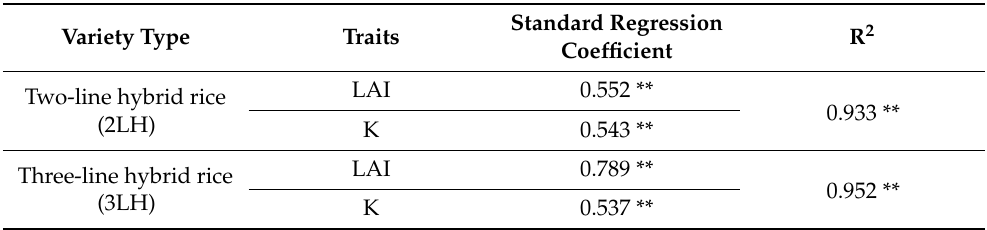
Table 6. Linear regression equations of LAI and K value at the heading stage for radiation intercep- tion